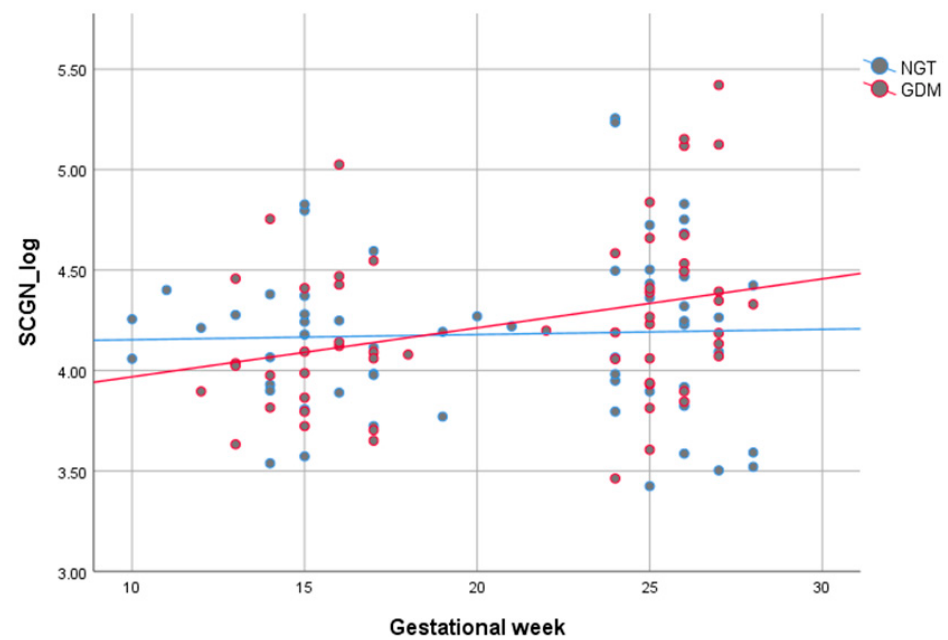
Figure 4. Grouped scatter dot plot according to glucose tolerance (blue = NGT, red = GDM) depicting the correlation of secretagogin (SCGN) (log-transformed) with week of gestation during pregnancy between week of gestation (GW) 10 and 28. In women with GDM, SCGN correlated positively with week of gestation ( r p = 0.308, p = 0.021). NGT displays the same trend, albeit not statistically significant ( r p = 0.035, p = 0.791). NGT: normal glucose tolerance; GDM: gestational diabetes mellitus.